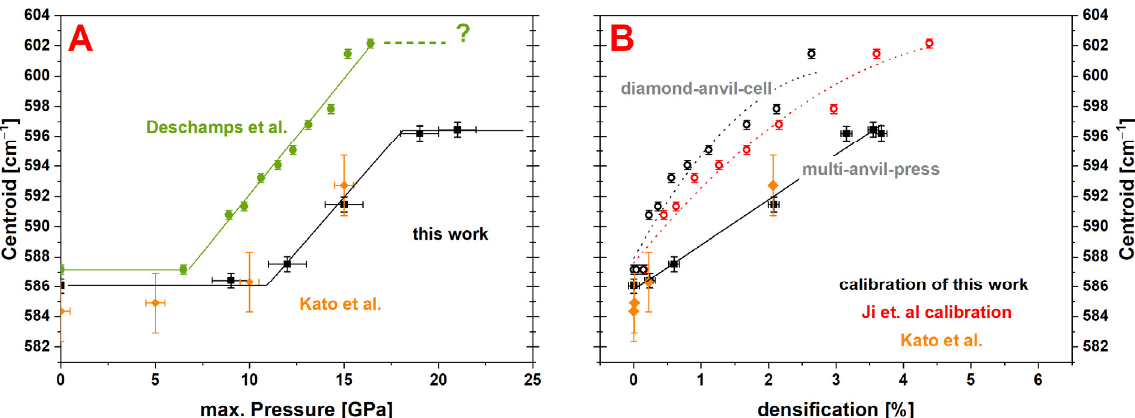
Figure 10. ( A ) Comparison of the Raman main band centroid evolution over the maximum pressure (black ≙ this work; green ≙ Deschamps et al.; orange ≙ Kato et al.); good overall agreement between the study of Kato et al. (MAP-densification) and the values determined in this work with the first structural variation starting at P onset = 11.8 ± 0.3 GPa and a plateau after P end = 18.0 ± 0.3 GPa at ~596 cm − 1 ; values reported by Deschamps et al. show an earlier structural variation around 7 GPa and higher saturation value of ~602 cm − 1 ; the discrepancy to Deschamps et al. could originate from the less hydrostatic conditions of the DAC used for compression. ( B ) Comparison of calibrations done with the Raman main band region (black ≙ this work; orange ≙ Kato et al.); filled symbols represent direct calibrations using MAP and are equivalent and linear; hollow symbols and guide for the eye (dotted curves) are generated by using the centroid data of Deschamps et al. (DAC) and the densification P max calibration of this work (black) respectively the calibration of Ji et al. (red).